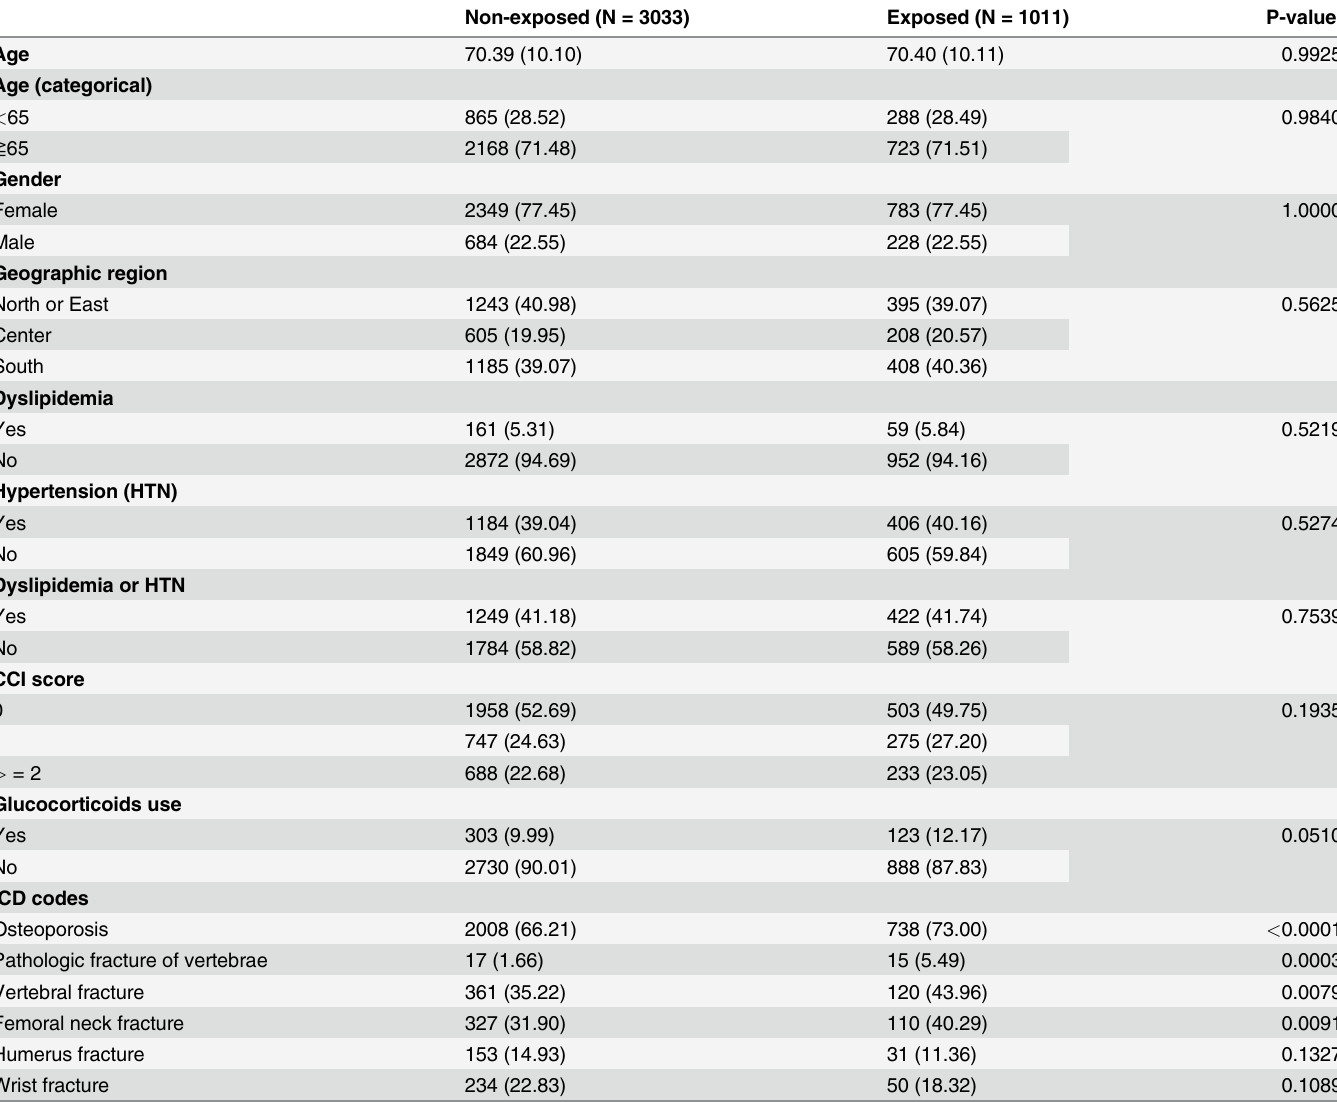
Table 1. Demographic Characteristics of exposed and non-exposed